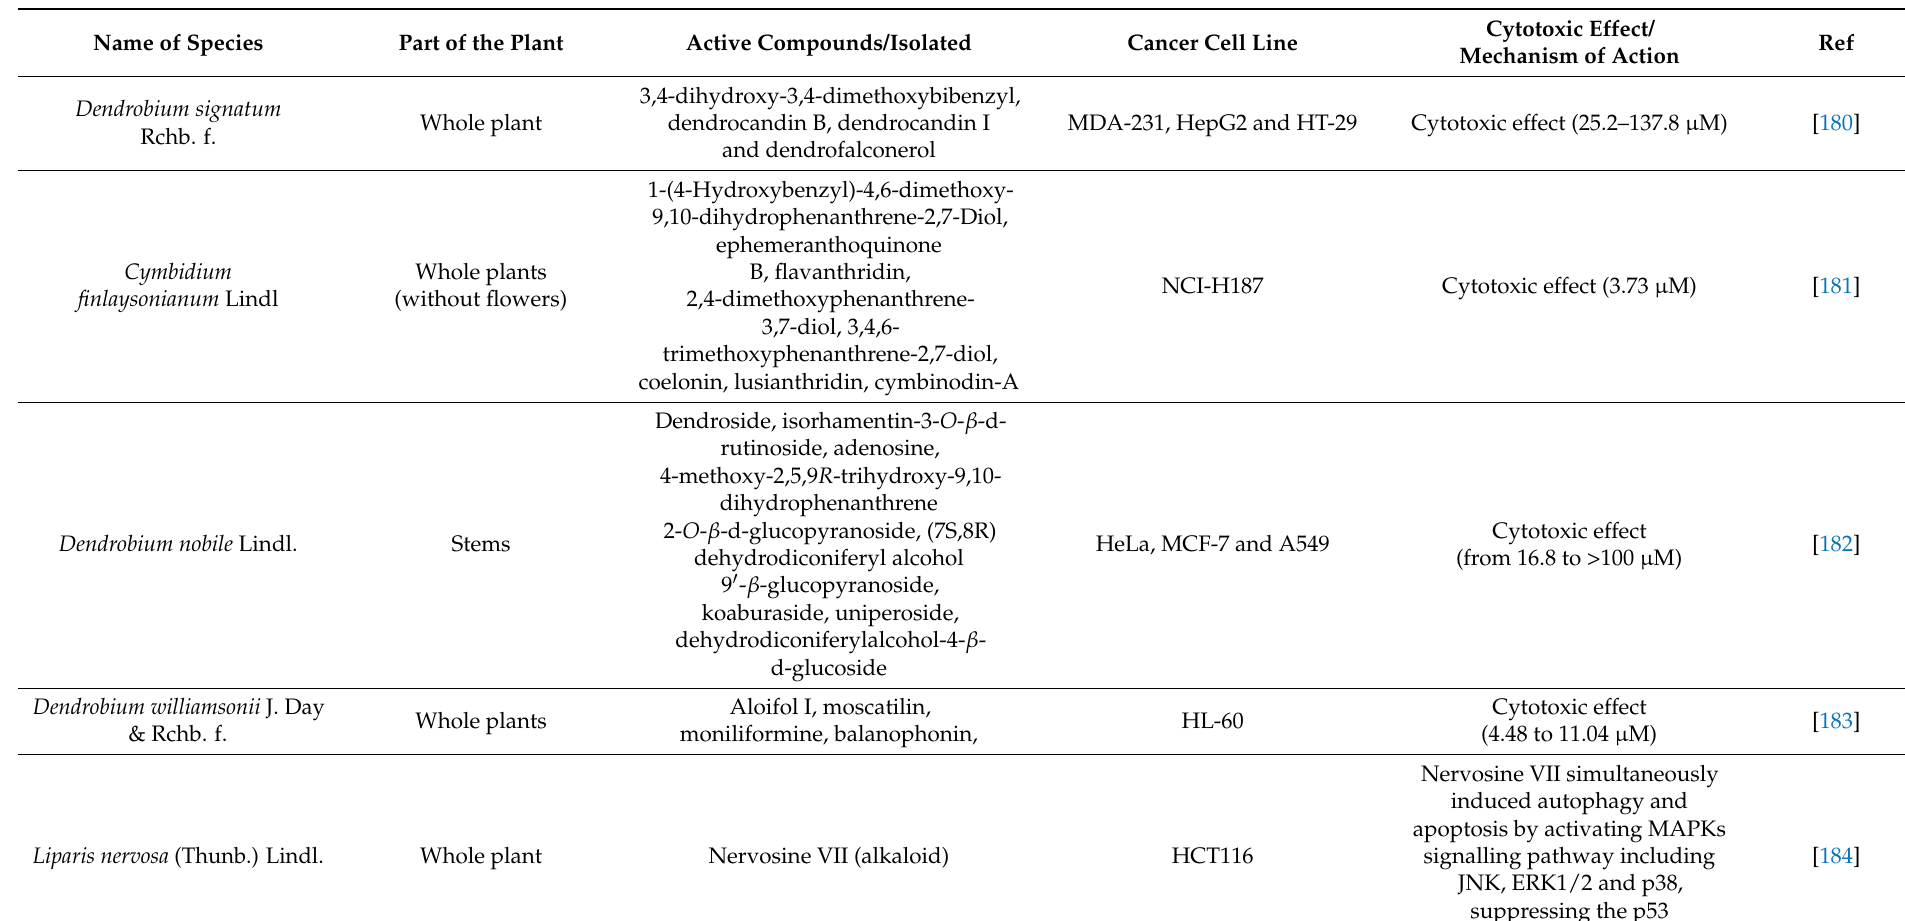
Table 2. Cytotoxic effect and potential mechanism of action of pure compounds or fractions from